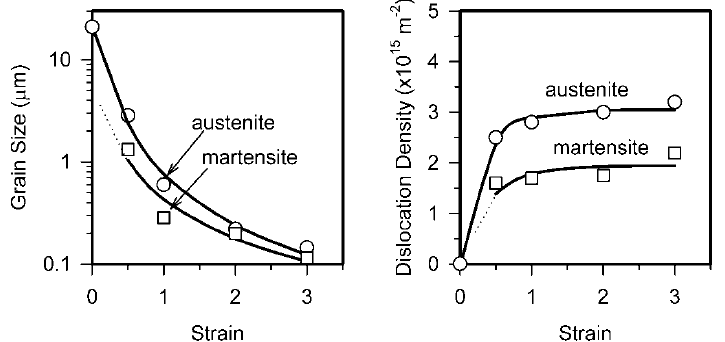
Figure 5. The effect of cold rolling strain on the transverse grain size and dislocation density in austenite and strain-induced martensite in a 304L stainless steel.